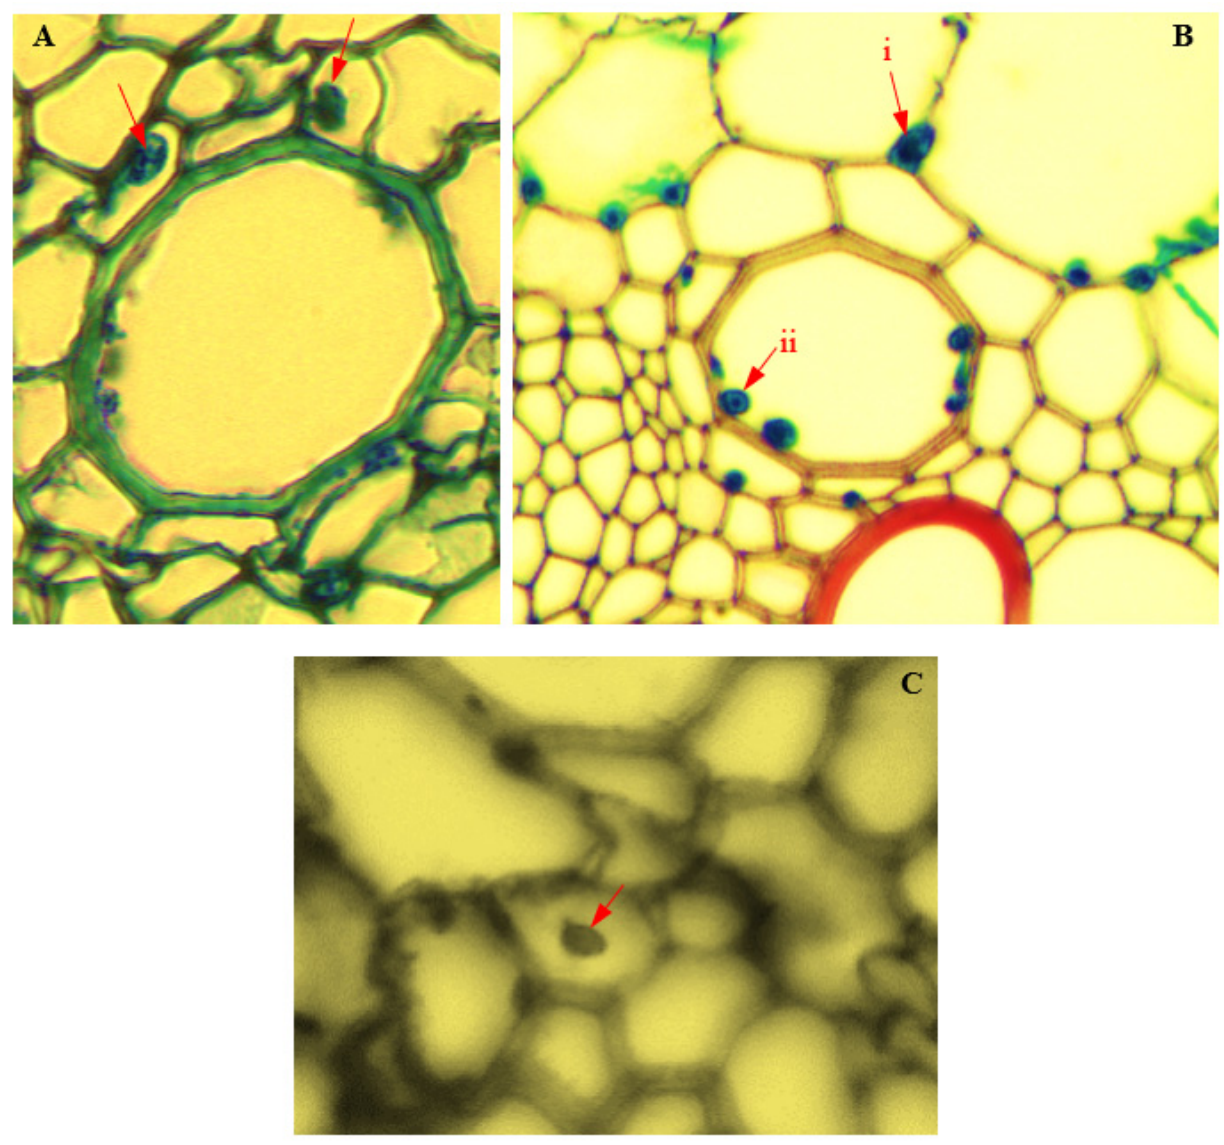
Figure 16. Light micrographs showing endophytic colonization of corn tissues by Penicillium citrinum (Magnification 400 × ). Red arrows indicate the position of endophyte in infected cells of ( A ) root pith; ( B ) i: stem bundle sheath; ii: stem metaxylem; and ( C ) leaf